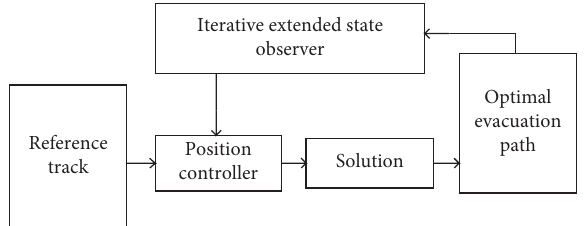
Figure 1: Calculation